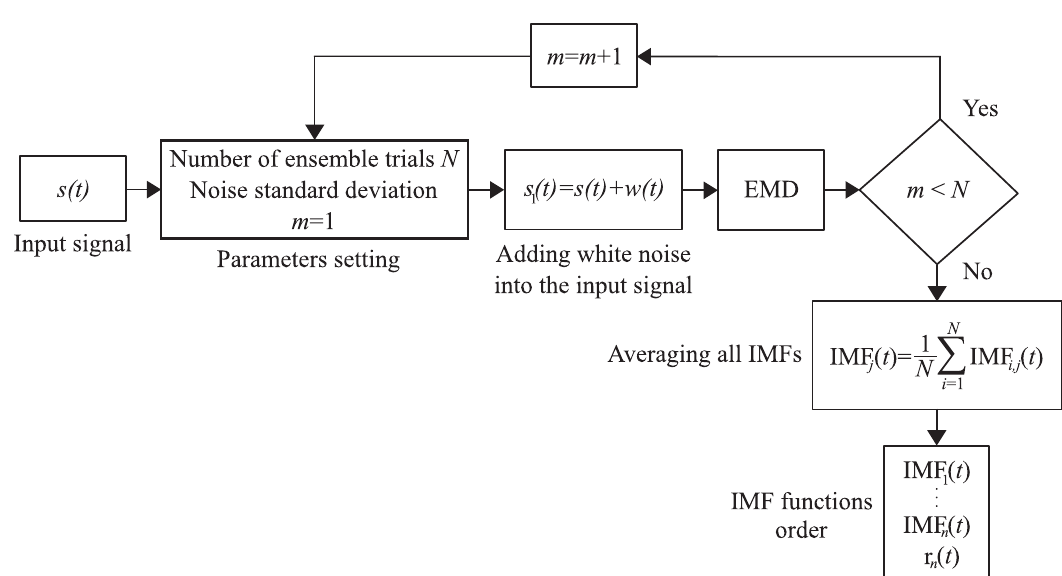
Fig 2. Block diagram of the EEMD. The method works on the principle of adding white noise into the input signal and performing N ensemble trials. The final IMFs are obtained by averaging the results of these trials, the r n ( t ) is a residual signal.